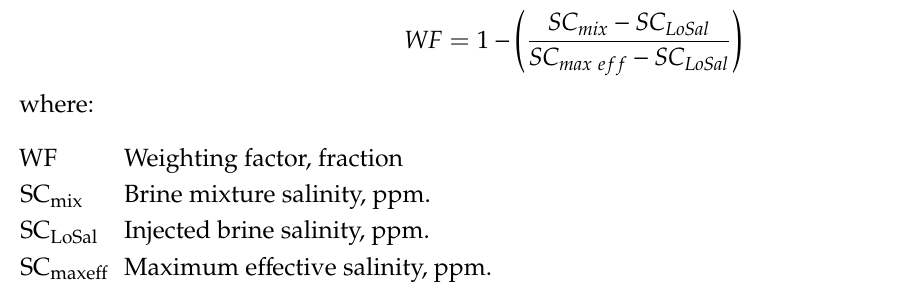
SC maxe ff Maximum e ff ective salinity, ppm.